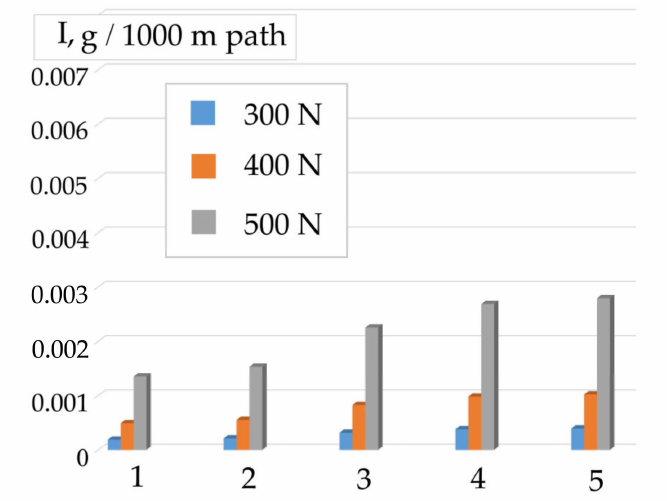
Figure 3. The reduced wear of steel 45. Contact with liquids: 1—Shell HF-E 46 (synthetic); 2—Shell HF-R (biological origin); 3—LCL r 3%; 4—LCL r 5%; 5—LCL r